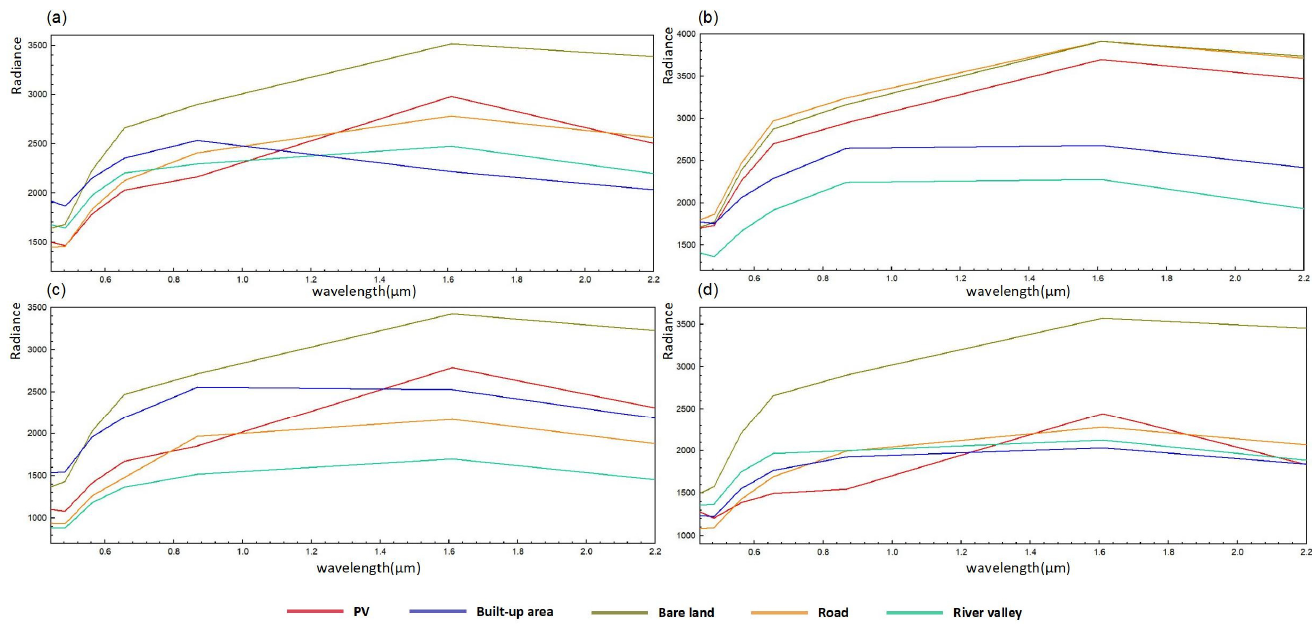
Figure 3. Spectral curves of PV plants and confusing land cover types in ( a ) March, ( b ) May, ( c )